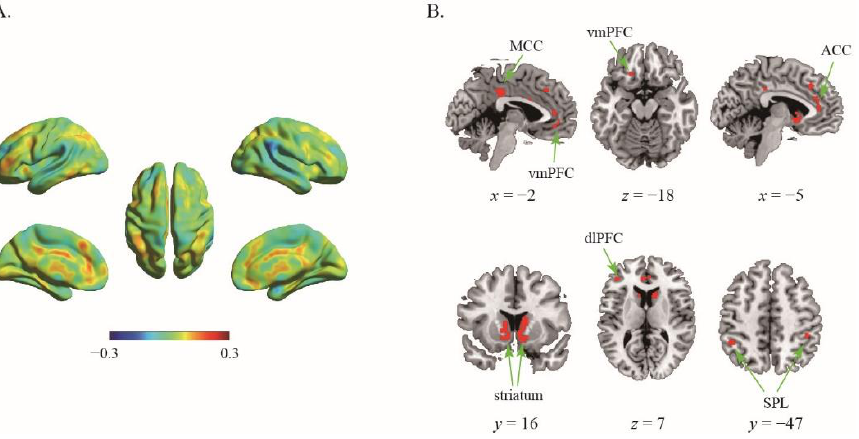
Figure 1. The results of first classifier. ( A ) The whole-brain weighted map. The color bar indicates weight value; ( B ) The top 1% voxels with highest weights (absolute value). weight value; ( B ) The top 1% voxels with highest weights (absolute